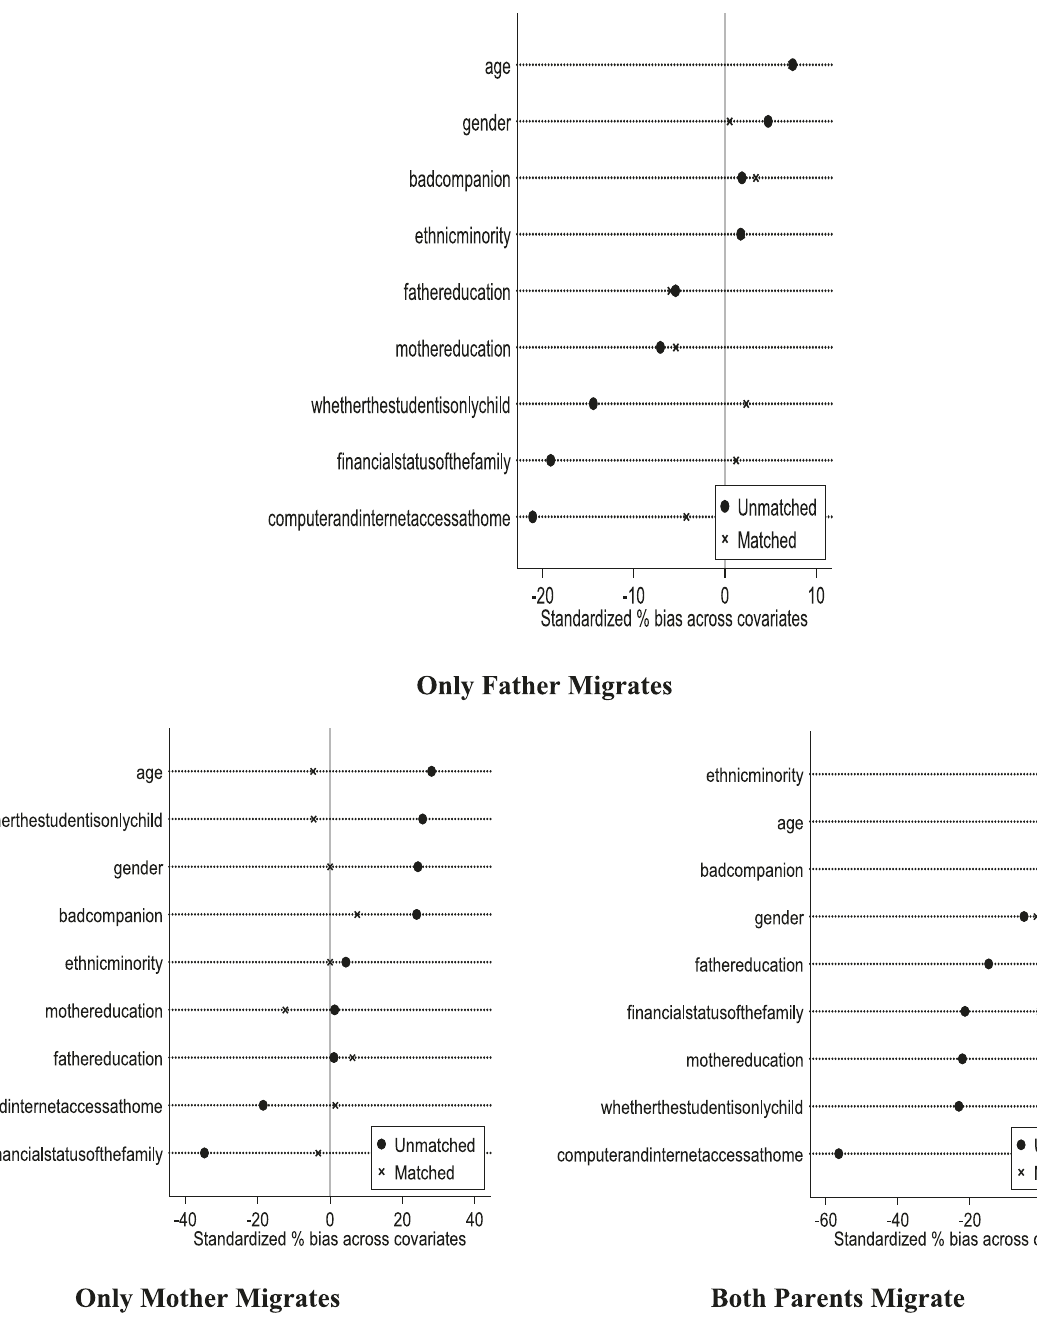
Fig. 1 Graphical balance diagnostic test. Graphical balancing diagnostic test of all the various migration models, namely only the father migrates, only the mother migrates, and both parents